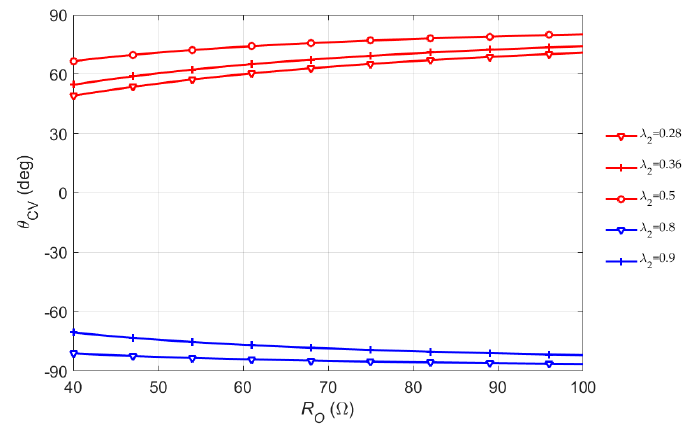
Figure 8. Phase angle of input impedance in CC mode.